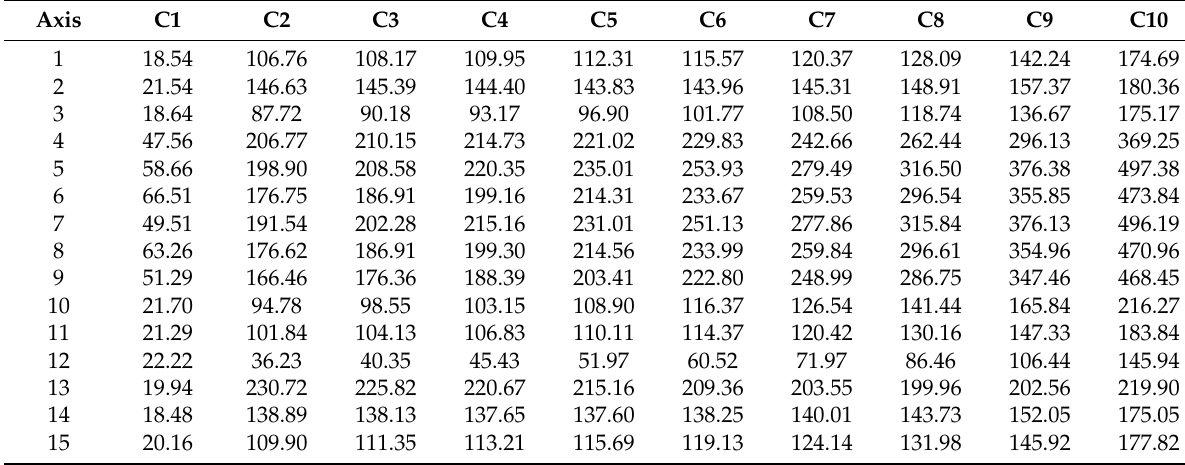
Table 9. Traction cable force (kN).